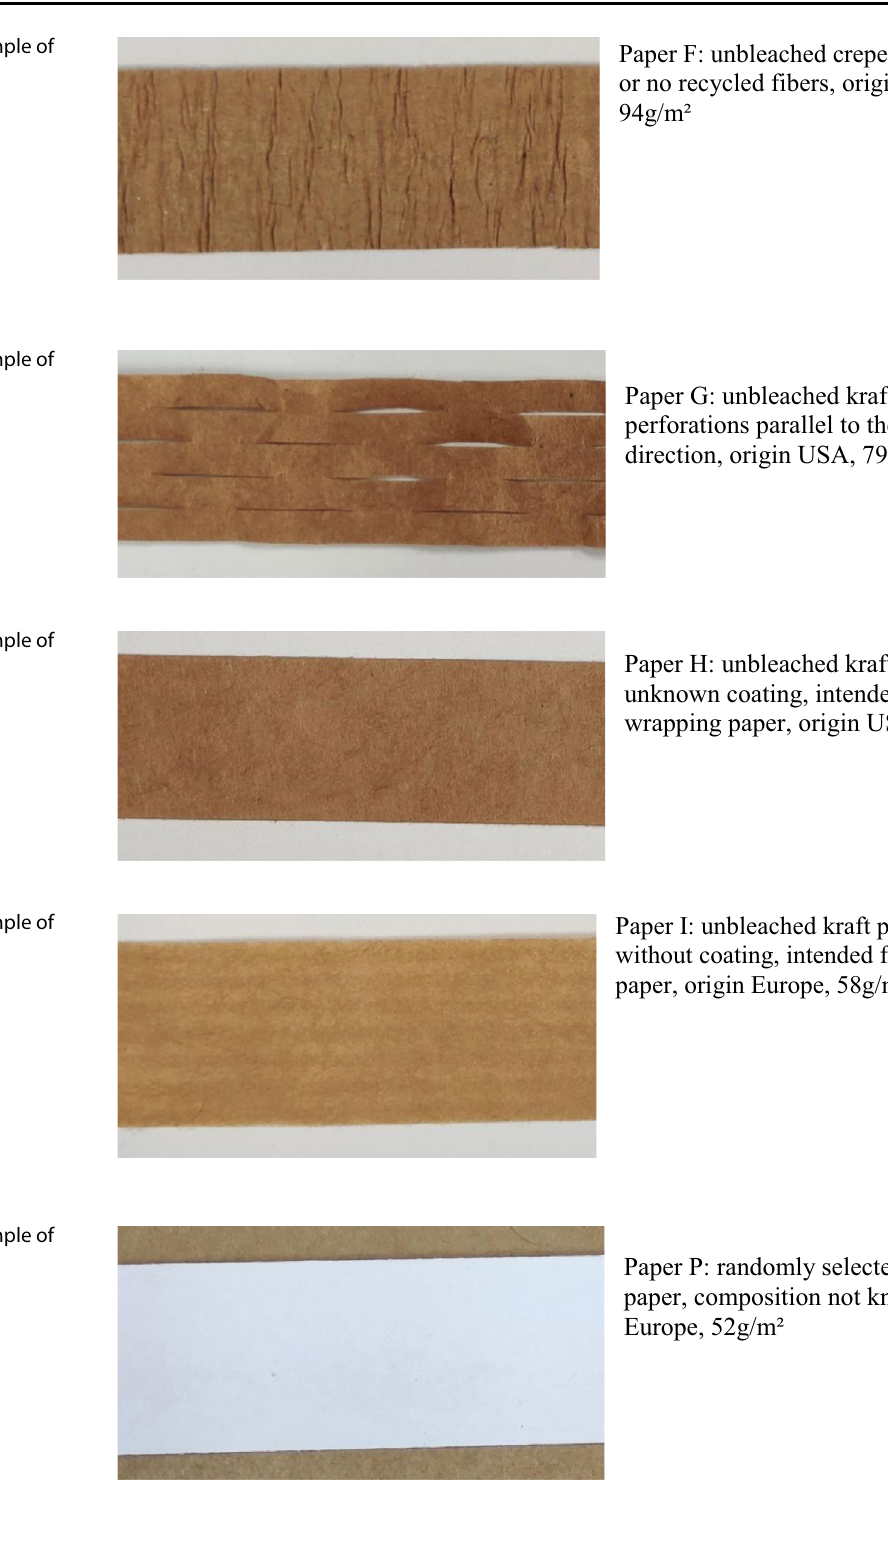
Paper F: unbleached crepe paper, little or no recycled fibers, origin Europe, 94g/m²